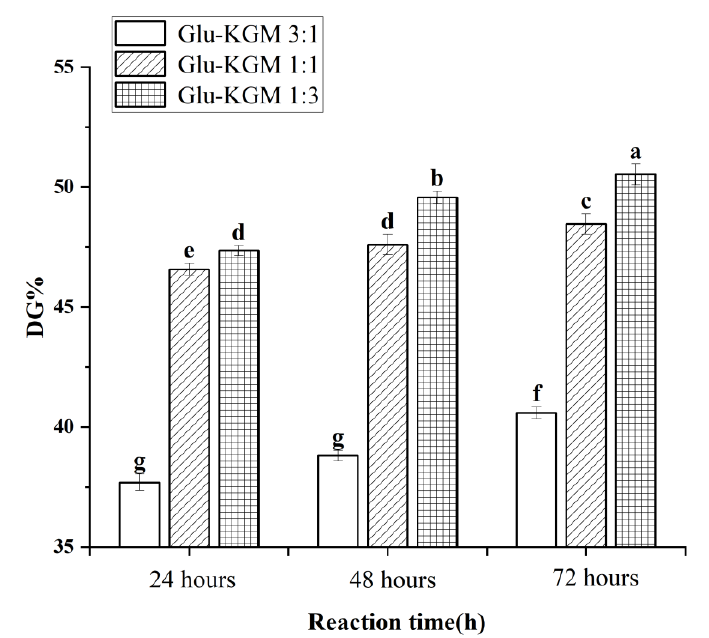
Figure 1. DG values of Glu-KGM conjugates with different proportions and reaction time. The results with different letters were significantly different ( p < 0.05).